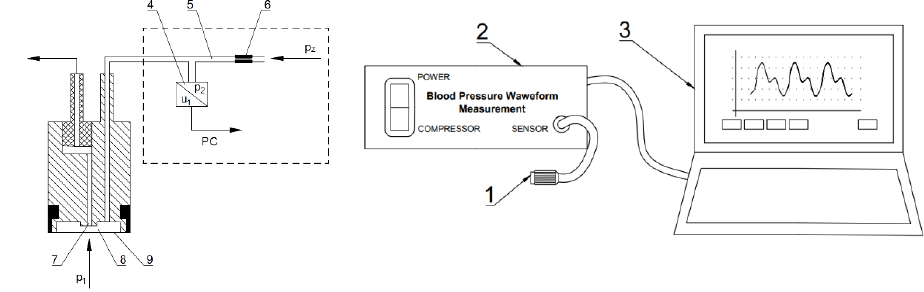
Fig. 1. Scheme of nozzle and electronic-pneumatic system (left) and device setup (right). (4 – pressure-voltage transducer, 5 – pneumatic wire, 6 – throttle, 7 – vent nozzle, 8 – measurement